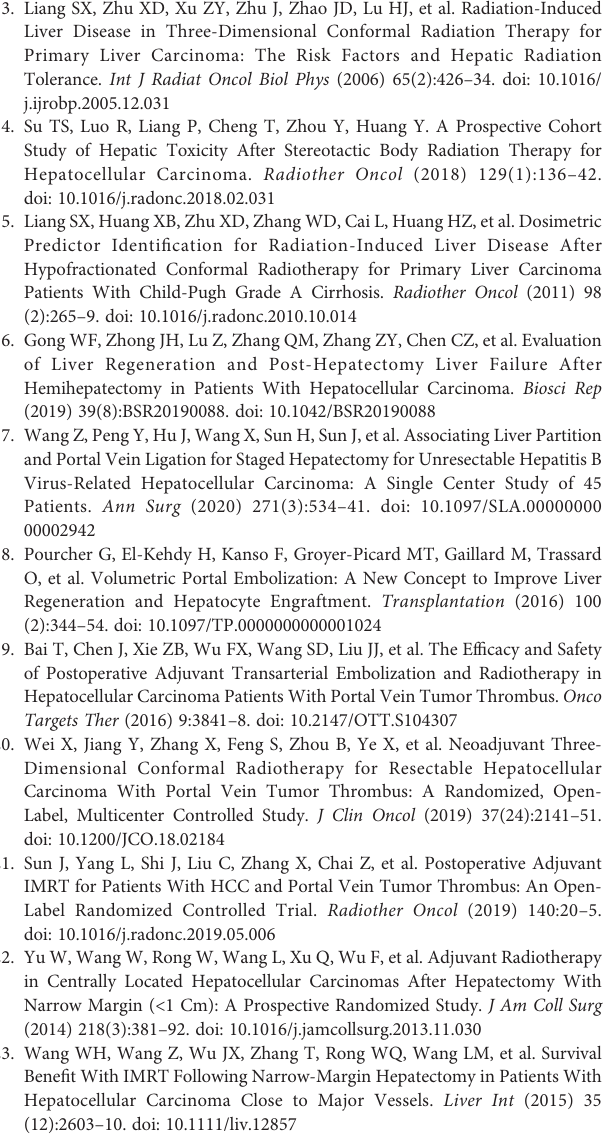
Supplementary Figure | The AUC of the training and testing model using ROC